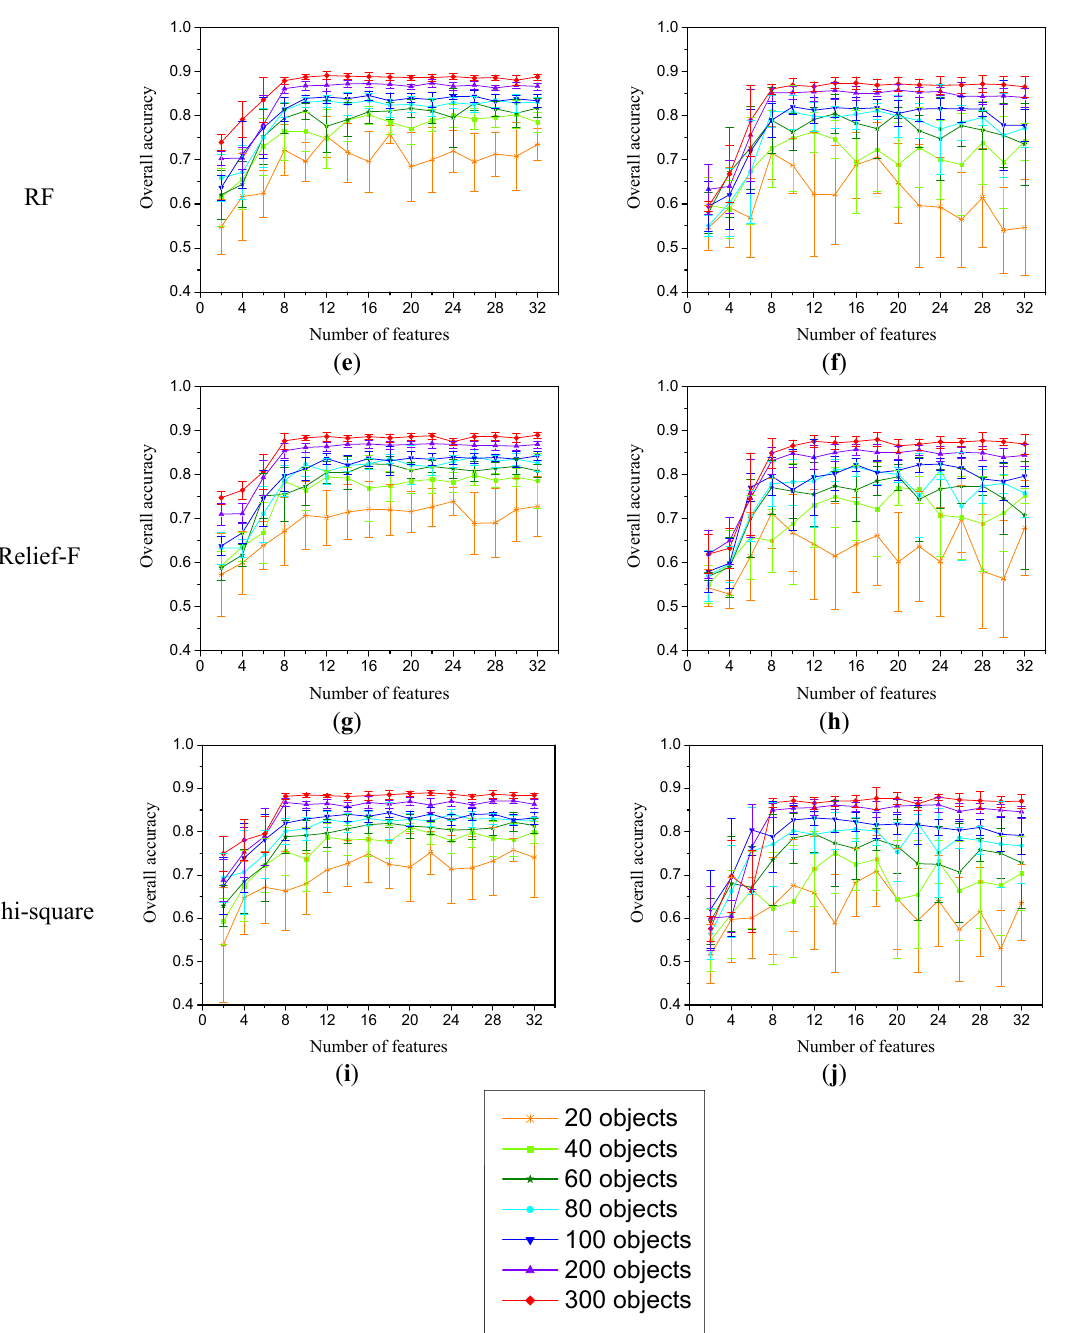
Figure 2. For area 1, the relationship between the mean overall accuracy of classifications repeated ten times (fixed numbers of features and training set size) and the number of features using five feature-importance-evaluation methods with different training set sizes for both classifiers.